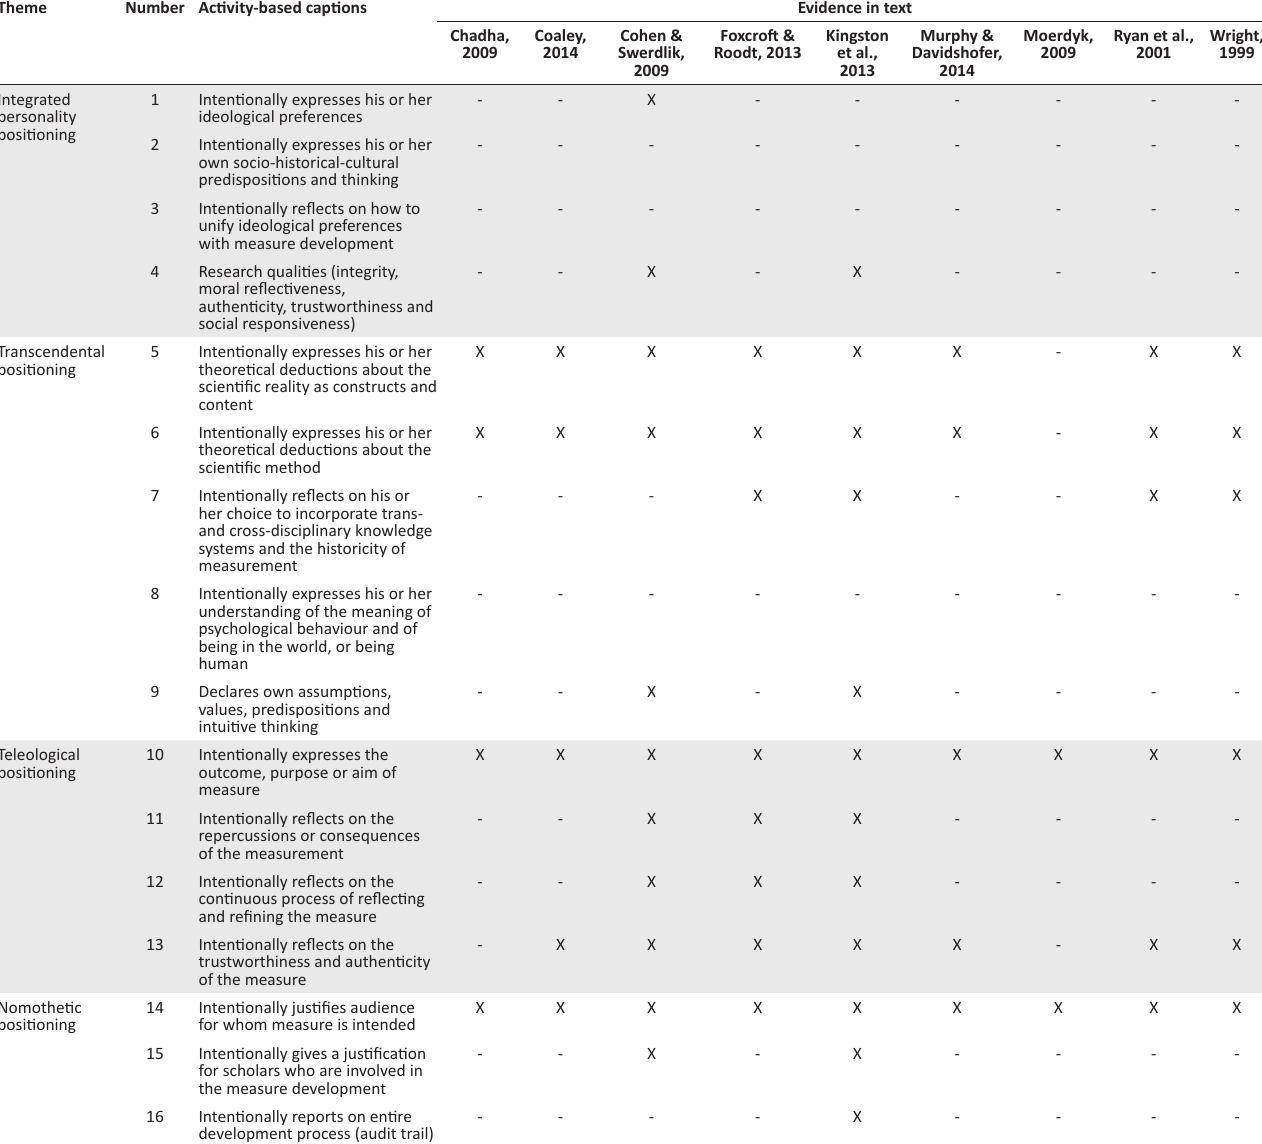
TABLE 2: Exploring philosophical provisions within psychometric literature pertaining to the ‘conceptualisation